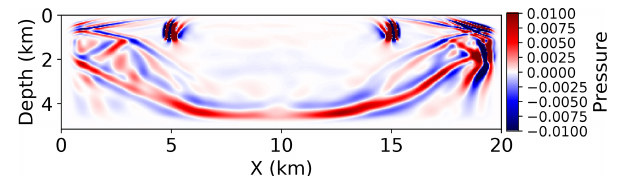
Figure 5. A 2D slice of the last time step of the reference solution. The wave has spread through most of the domain. The values in this figure have been thresholded to ± 0 . 01 for easy visualization. For pressure amplitudes, see Fig. 6.